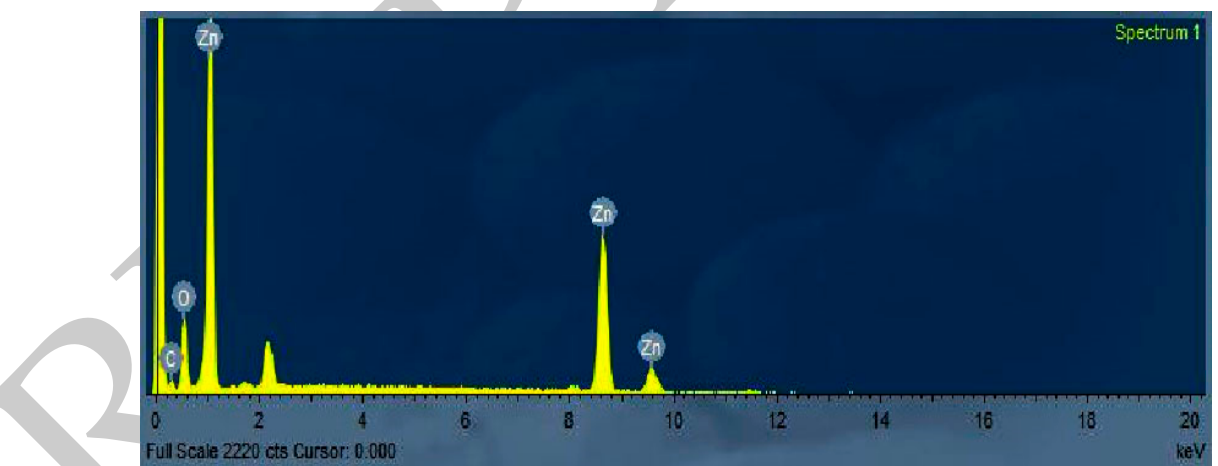
Figure 6. Energy dispersive X-ray analysis ( EDX) for (ZnO-NPs) confirm the high purity of ZnO NPs (79% of Zn and 20% of O).